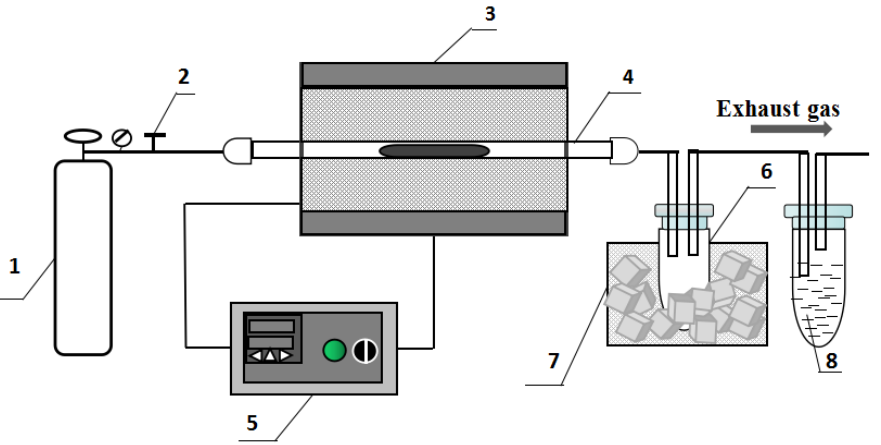
Figure 1. Schematic diagram of fixed-bed experimental device. 1—N 2 cylinder, 2—flowmeter, 3—electric heating furnace, 4—quartz tube, 5—program temperature controller, 6—coal tar collector, 7—ice water, 8—HCl solution.